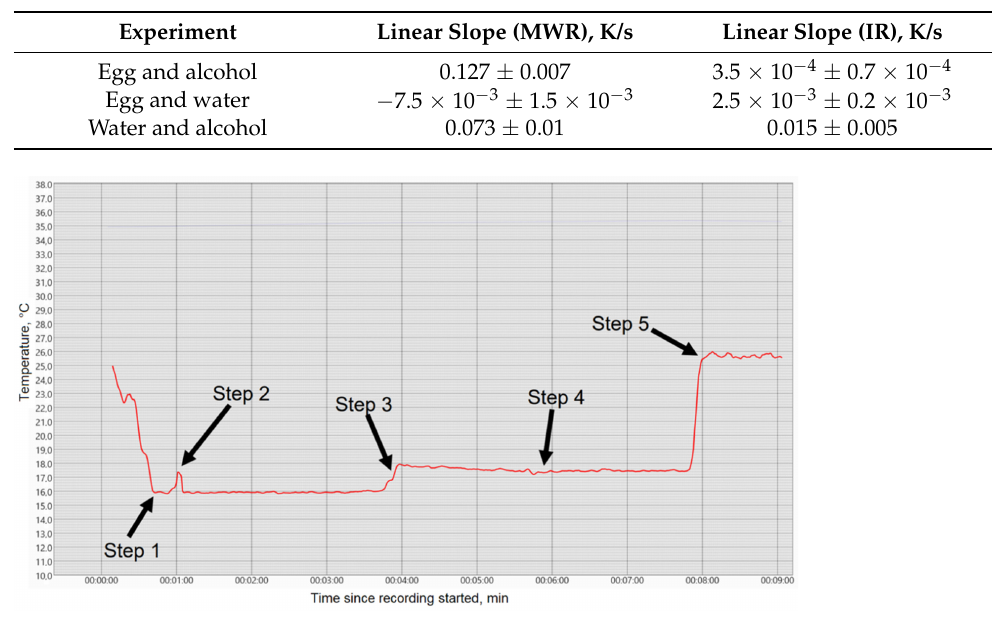
Figure 3. Time dependences were obtained using MWR Dynamics software (MMWR LTD). Step 1. Add egg whites; Step 2. Immerse probe and IR thermometer in the cup; Step 3. Add ethanol 96%; Step 4. Stir; Step 5. Remove probe. Table 1. Rate constants.